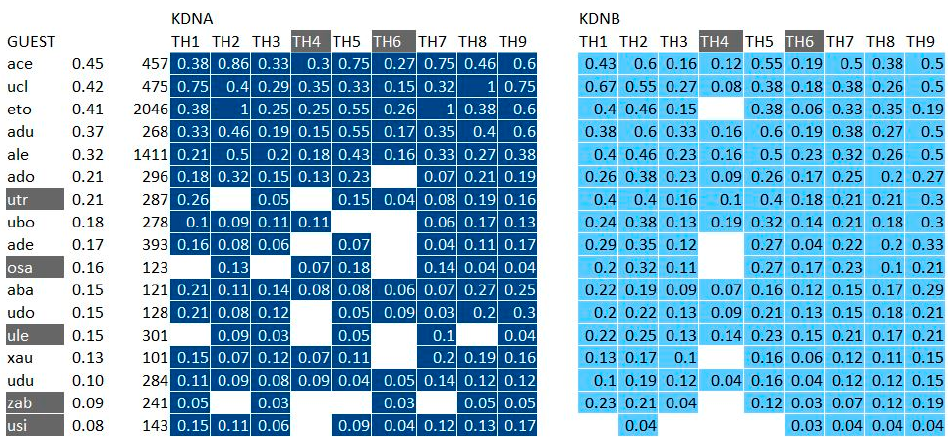
Figure 14. KDNA and KDNB proximities between 17 guests and the 9 topic hubs. KDNA (on the left, dark blue) exploits the trails of the targeted guest whereas KDNB (on the right, light blue) excludes the targeted guests’ trails but exploits all the trails of the others. Both these proximities have been normalized by max (KDNA, KDNB).